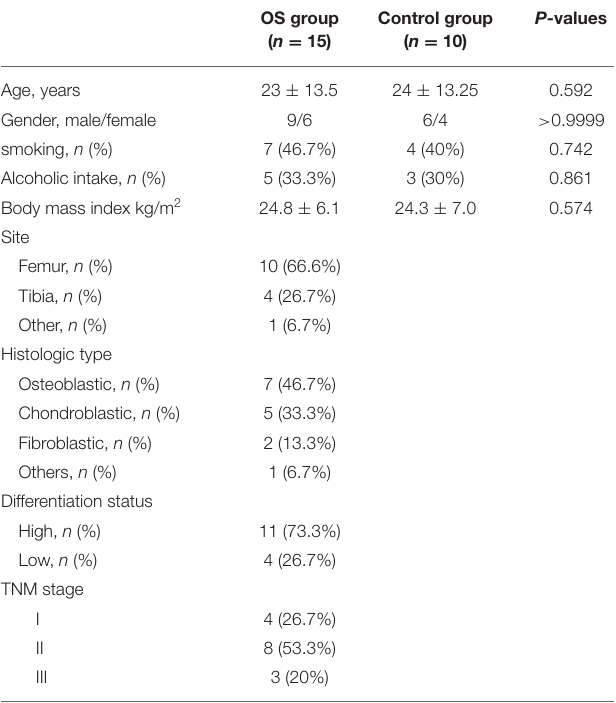
TABLE 1 | The baseline characteristics of all participants.